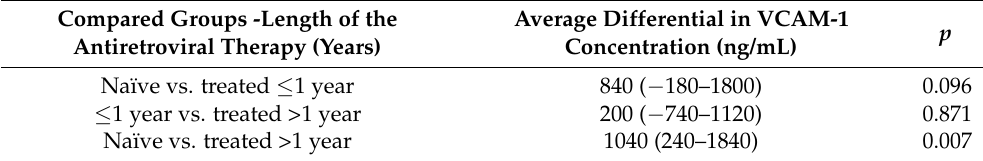
Table 3. Post hoc tests assessing VCAM-1 concentrations and length of antiretroviral therapy using Tukey HSD test.